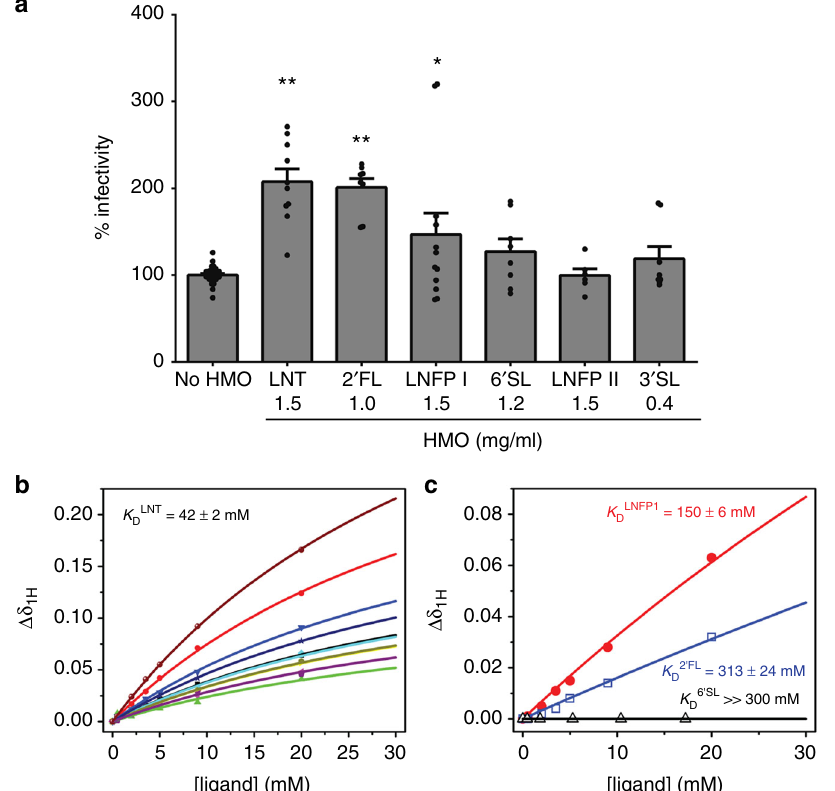
Fig. 3 Variable effects of HMOs identi fi ed from fi eld studies on rotavirus infectivity and VP8* binding. Of the HMOs identi fi ed as associated with rotavirus infections in the fi eld studies, only 2 ’ FL and LNFP I but not 6 ’ SL and LNFP II enhance G10P[11] infectivity in vitro ( a ). LNT was included as a positive control while 3 ’ SL that was not associated with rotavirus infections in the fi eld studies was included as a negative control. All bars represent the mean percentage of infectivity with error bars denoting standard error of the mean from a minimum of three independent experiments. No HMO treatment was considered 100% infectivity. The mean baseline titer of G10P[11] used in these experiments (100% infectivity) was 8.8 × 10 5 fl uorescent focus units (FFU) per ml. p value <0.05 (analysis of variance with Dunnett ’ s post hoc test) was considered statistically signi fi cant (* p < 0.05, ** p < 0.001). Nuclear magnetic resonance (NMR) analysis shows differences in binding of HMOs to P[11] VP8* ( b , c ). The highest binding was seen with LNT ( b ) while no binding was seen with 6 ’ SL ( c ). The binding curves of NMR titrations of LNT to P[11] VP8* for nine representative NMR peaks of changes in proton chemical shifts are shown in different colors ( b ). The binding curves of NMR titrations of LNFP1, 2 ’ FL, and 6 ’ SL to P[11] VP8* for the same NMR peaks (greatest chemical shift change) are shown in red, blue, and black, respectively ( c